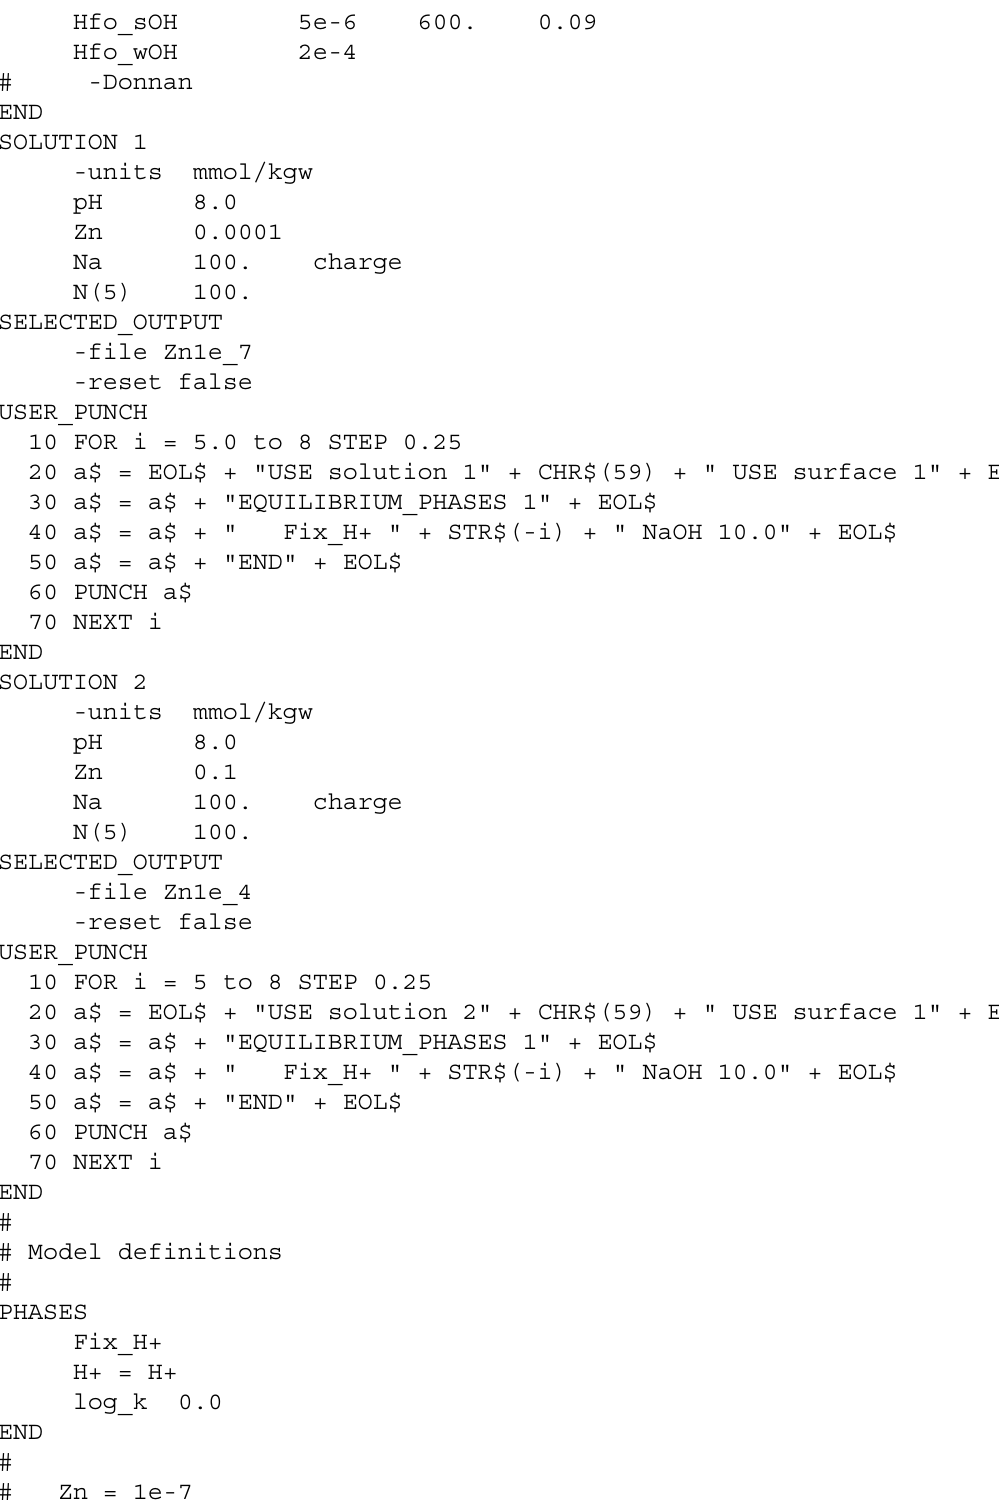
Table 27. Input file for example